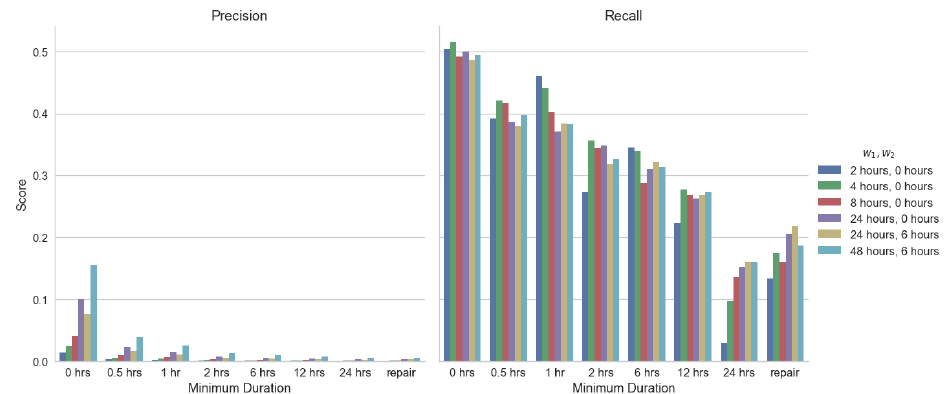
Figure 5. Cross-validation results for various minimum durations of downtime and pre-fault windows w 1 and w 2